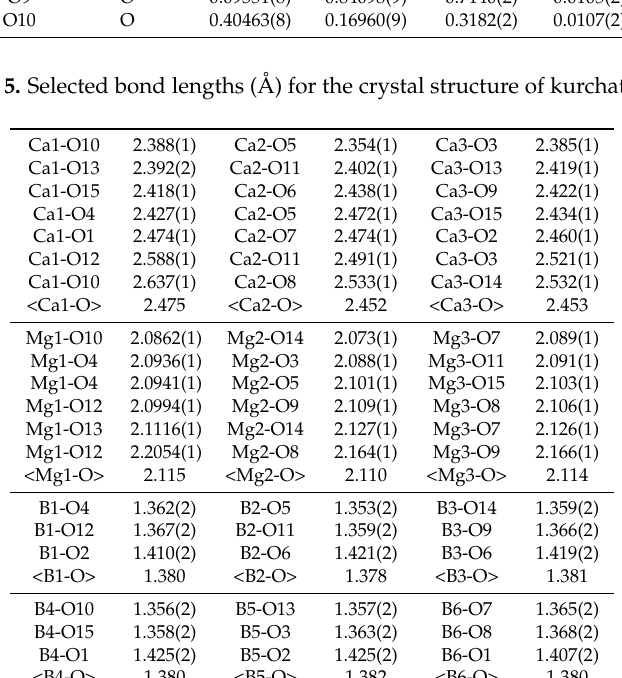
Table 5. Selected bond lengths (Å) for the crystal structure of kurchatovite.